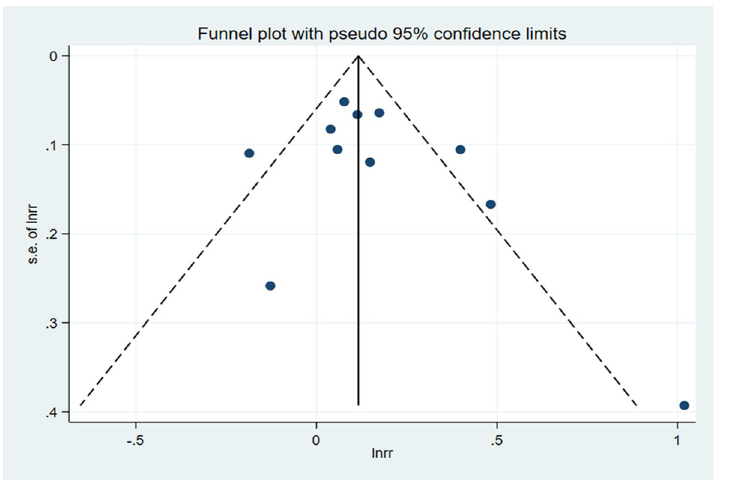
Fig 3. Funnel plot for the association between GI and lung cancer